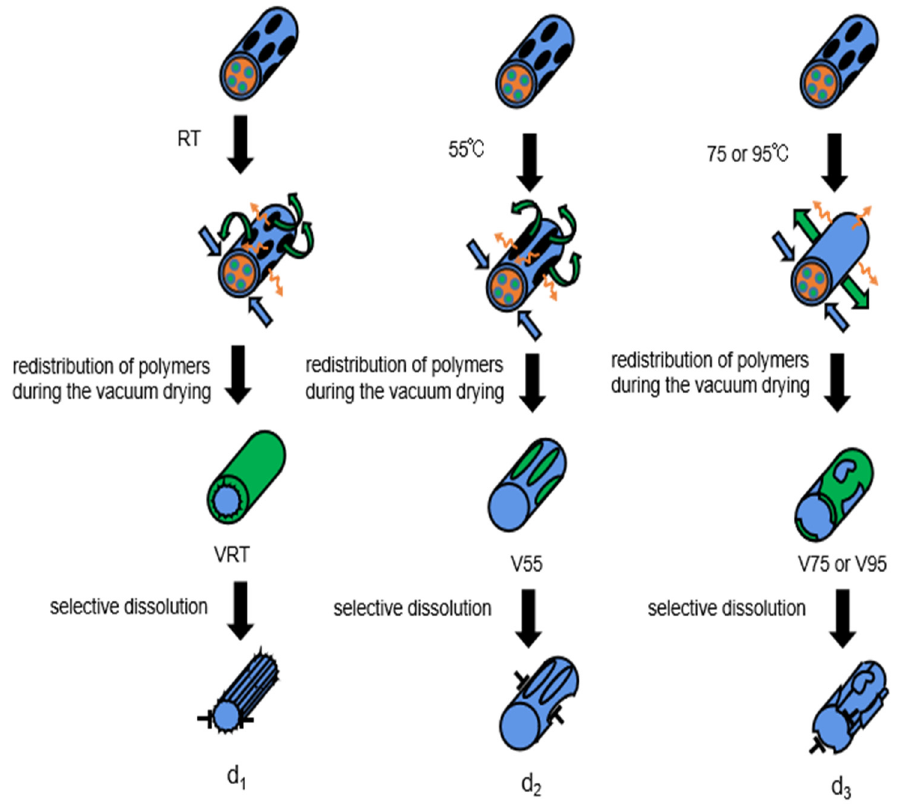
Figure 4. Surface reconstruction process during vacuum drying at various temperatures (Green, blue, orange, and black regions on the fiber represent PVP, PVA, water, and mesh voids, respectively. The green, blue, and orange arrows in the diagram represent the traveling directions of PVP, PVA, and water, respectively).